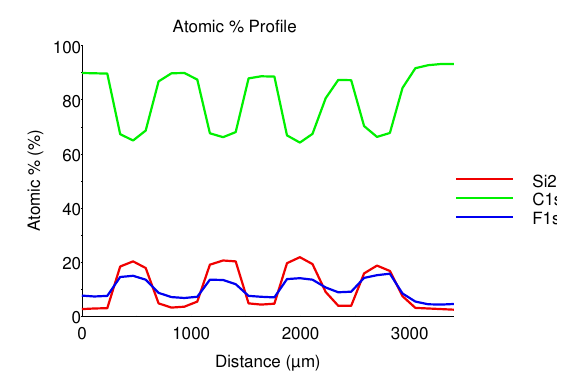
Fig. 5: Plot of the reconstructed carbon, silicon and fluorine contents as determined by scan-line mode